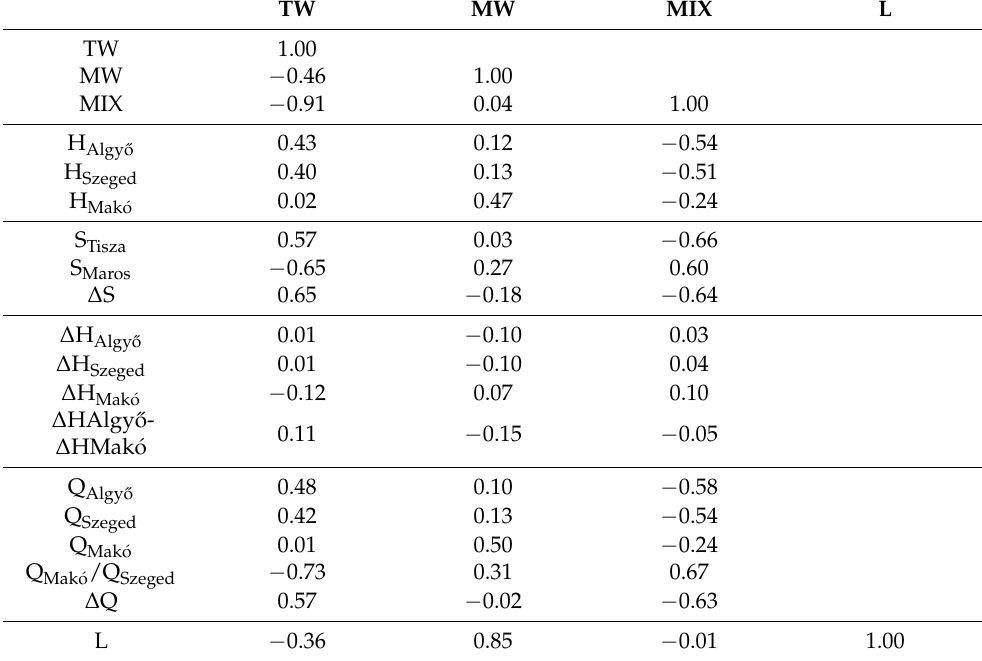
Table 3. Pearson correlation matrix between the areal distribution (%) of mixing waters (TW, MW and, MIX), longitudinal extent (L) of Maros water (MW) in the confluence area, and the various hydrological parameters. TW MW MIX L TW 1.00 MW − 0.46 1.00 MIX − 0.91 0.04 1.00 H Algy˝o 0.43 0.12 − 0.54 H Szeged 0.40 0.13 − 0.51 H Mak ó